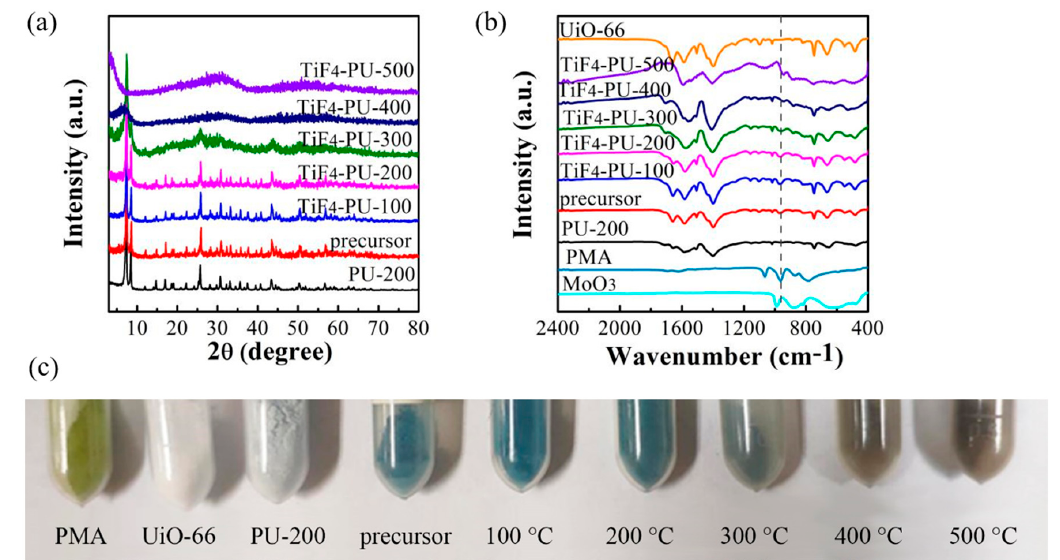
Figure 1. ( a ) XRD patterns of TiF 4 -PU obtained at different calcination temperatures. ( b ) FT-IR spectra of TiF 4 -PU obtained at different calcination temperatures. ( c ) The images of the samples (PMA, UiO-66, PU-200, TiF 4 -PU precursor, and TiF 4 -PU obtained at 100, 200, 300, 400, 500 ° C).